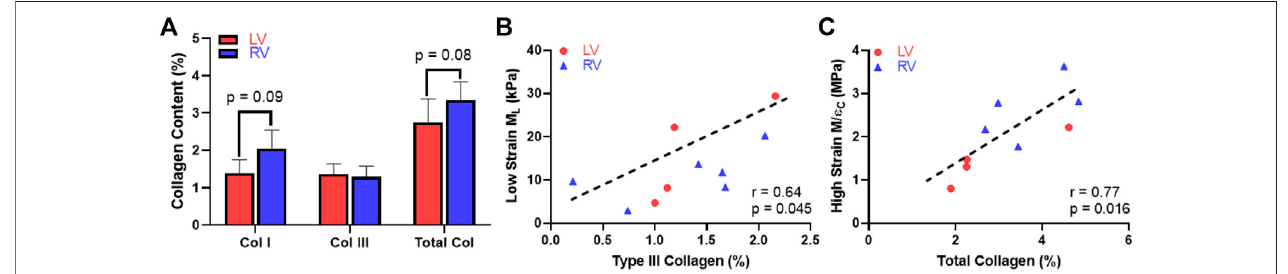
FIGURE7| Histologicalmeasurementandcorrelationanalysisforthecollagen. (A) Variationsinthecontentofcollagenisoformsandthetotalcollagenbetweenthe LVandRV, (B) Signi fi cantcorrelationbetweenthetypeIIIcollagencontentandlongitudinal M ( M L )atthelow-strainrangeand (C) Signi fi cantcorrelationbetweenthetotal collagen content and circumferential M/ ε at the high-strain range.